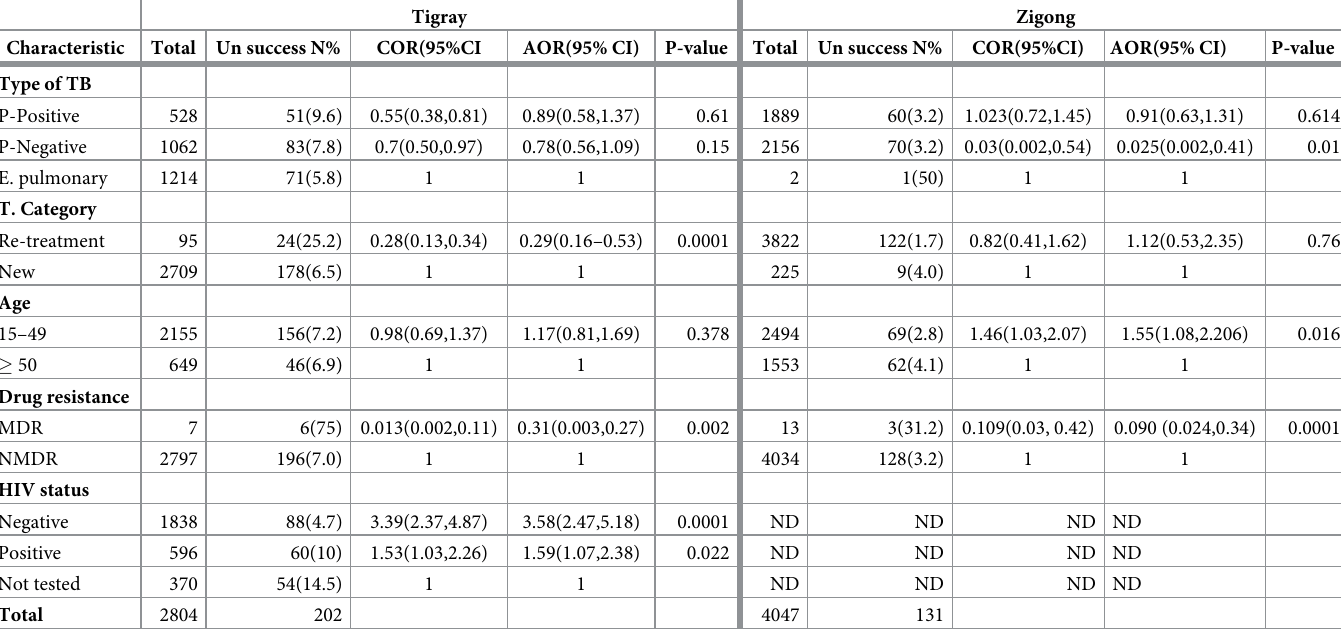
Treatment success is sum of patients cured and those who have completed treatment. Hence, patient compliance is a key factor in treatment success [10]. In this study, the overall treatment success rate of all TB cases was 92% in Tigray and 96.6% in Zigong. The finding of Tigray was similar with studies done in west Gojjam, Sidama and Addis Ababa 91.5% [17, 20, Table 4. Multiple logistic regression factors affecting treatment outcome of women in Tigray and Zigong January 2007 December 2016 N = 2084 and N = 4047. Tigray Zigong